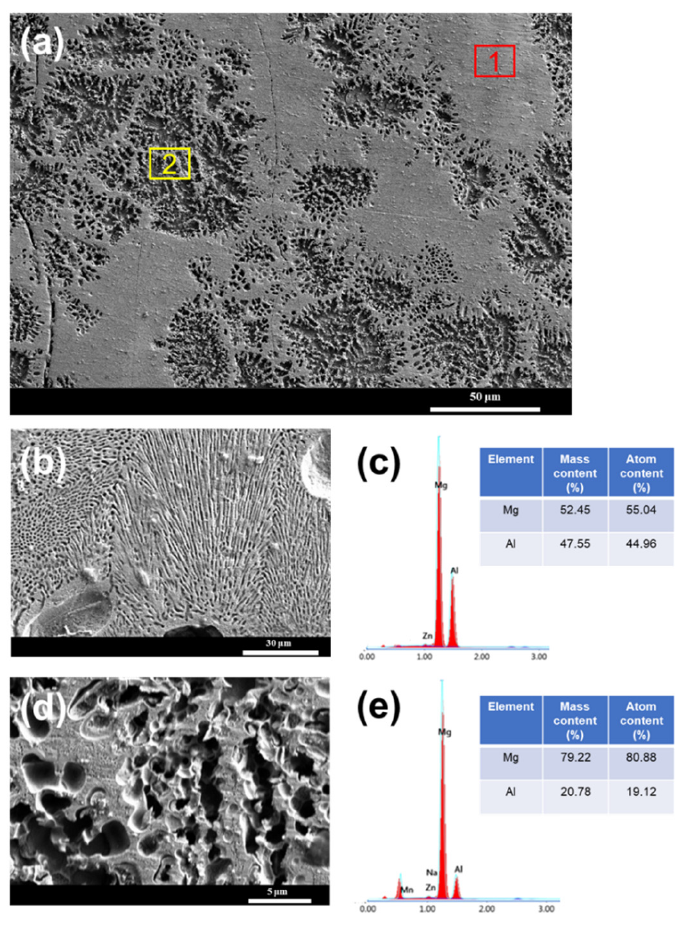
Figure 9. Distribution of Mg and Al elements in the turbulence area between the arc zone and laser zone. ( a ) SEM image of the turbulence area, ( b ) morphology of area 2 in image a, ( c ) EDS results of area 1, ( d ) morphology of area 1 in image a, ( e ) EDS results of area 2.